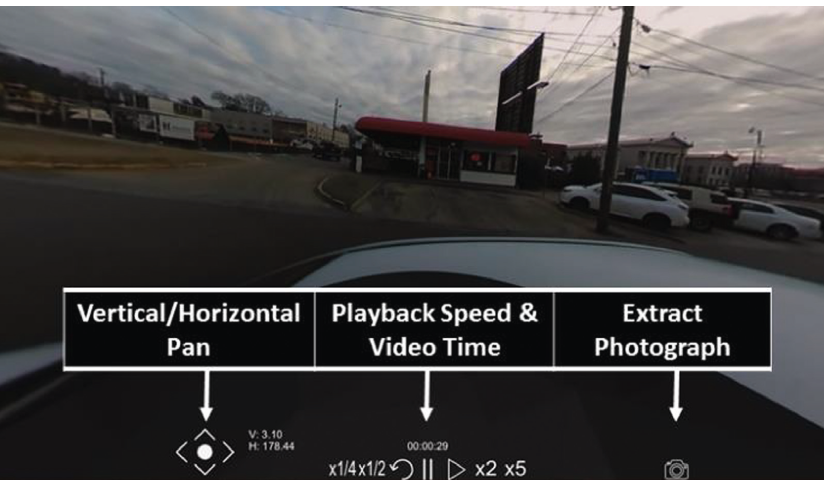
Figure 5: Extreme Events Video Capture tool video display window.